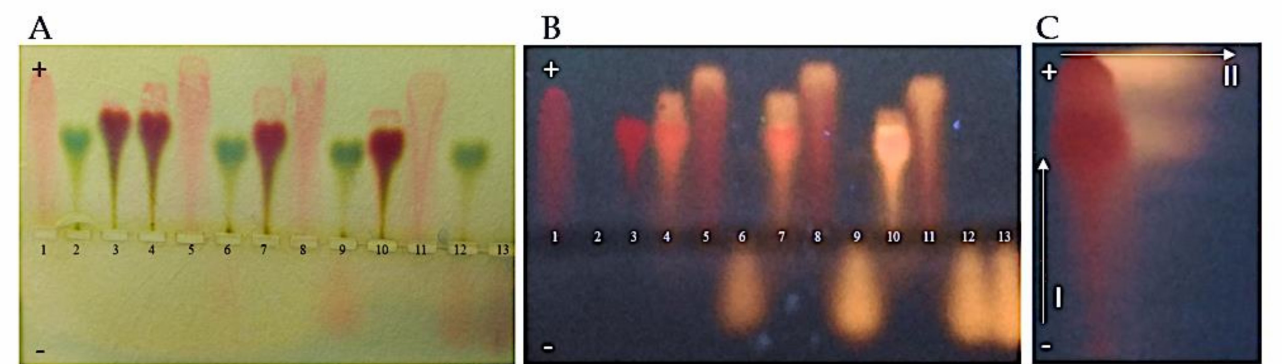
Figure 2. Complexes between BSA and CR–Dox. BSA free and in the complexes with CR or CR–Dox seen as migrating toward the anode; Dox free seen as migrating toward the cathode: (1) CR, (2)